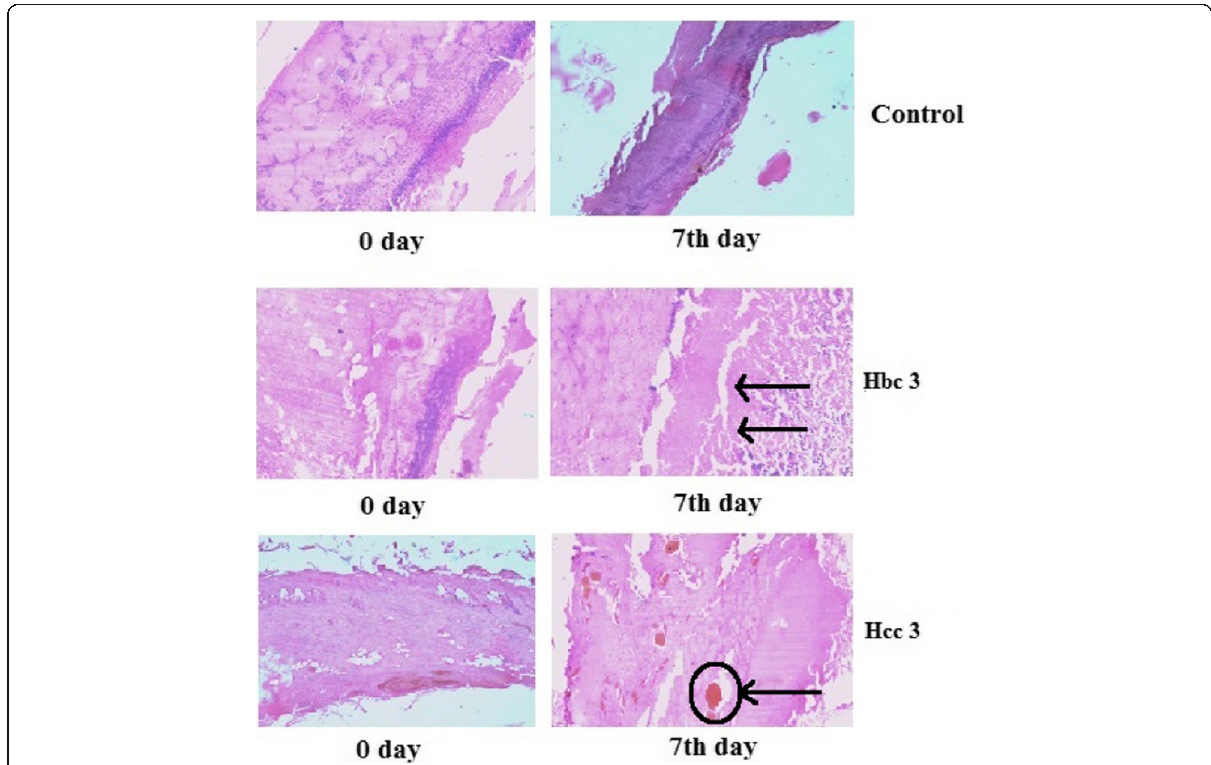
Fig. 7 Histopathological slides of treated